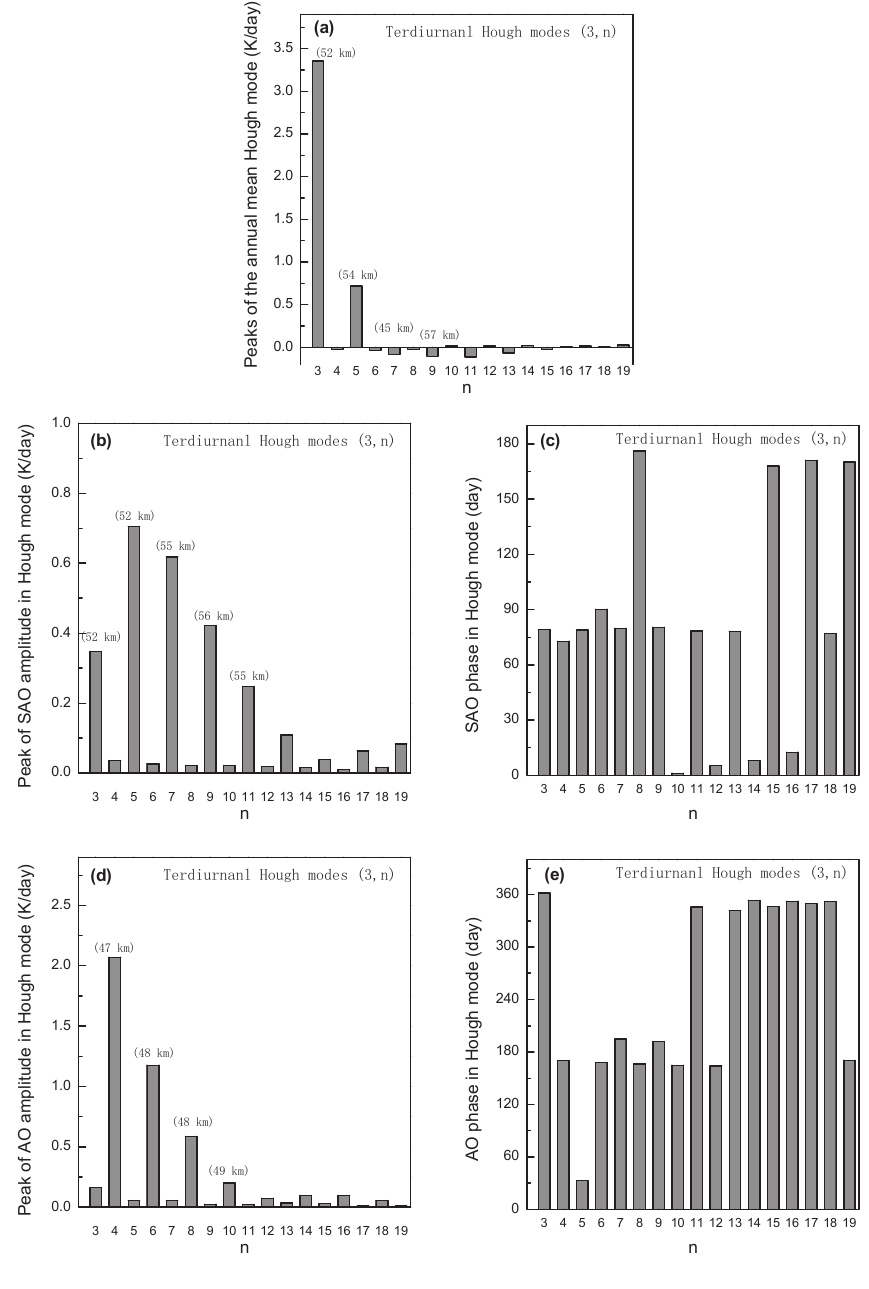
Fig. 15. The same as Fig. 12, but for terdiurnal Hough modes.